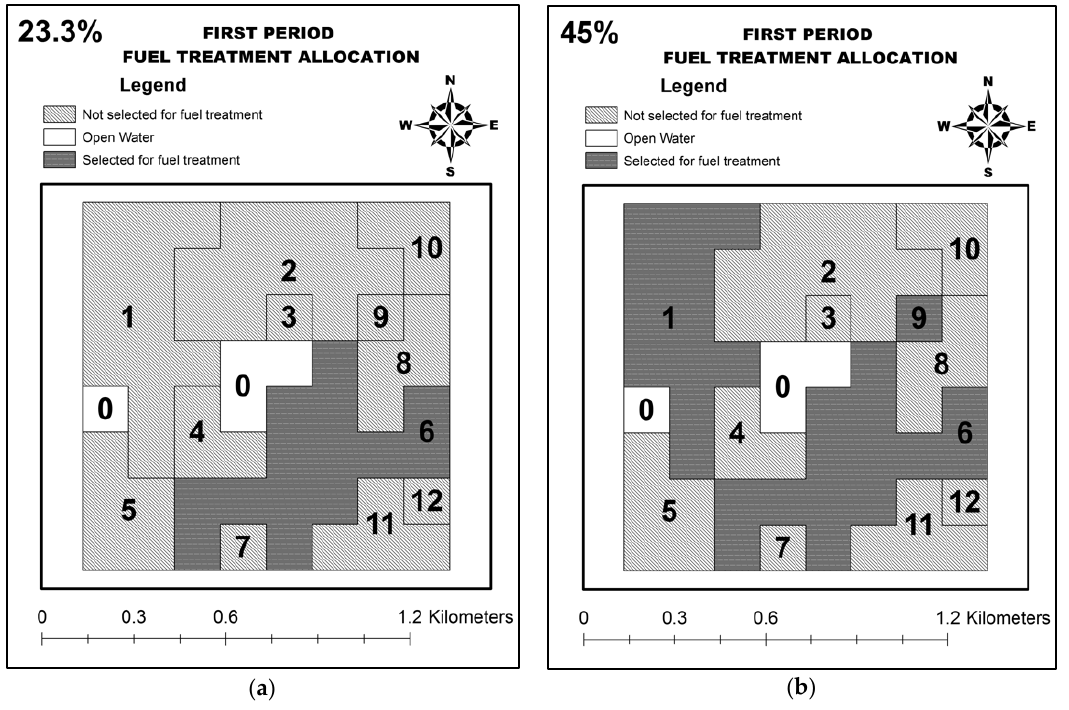
Figure 10. Stands selected for the first period fuel treatments as suggested by the best FT1 under different assumptions of forest protected value: ( a ) low FPV; ( b ) high FPV.